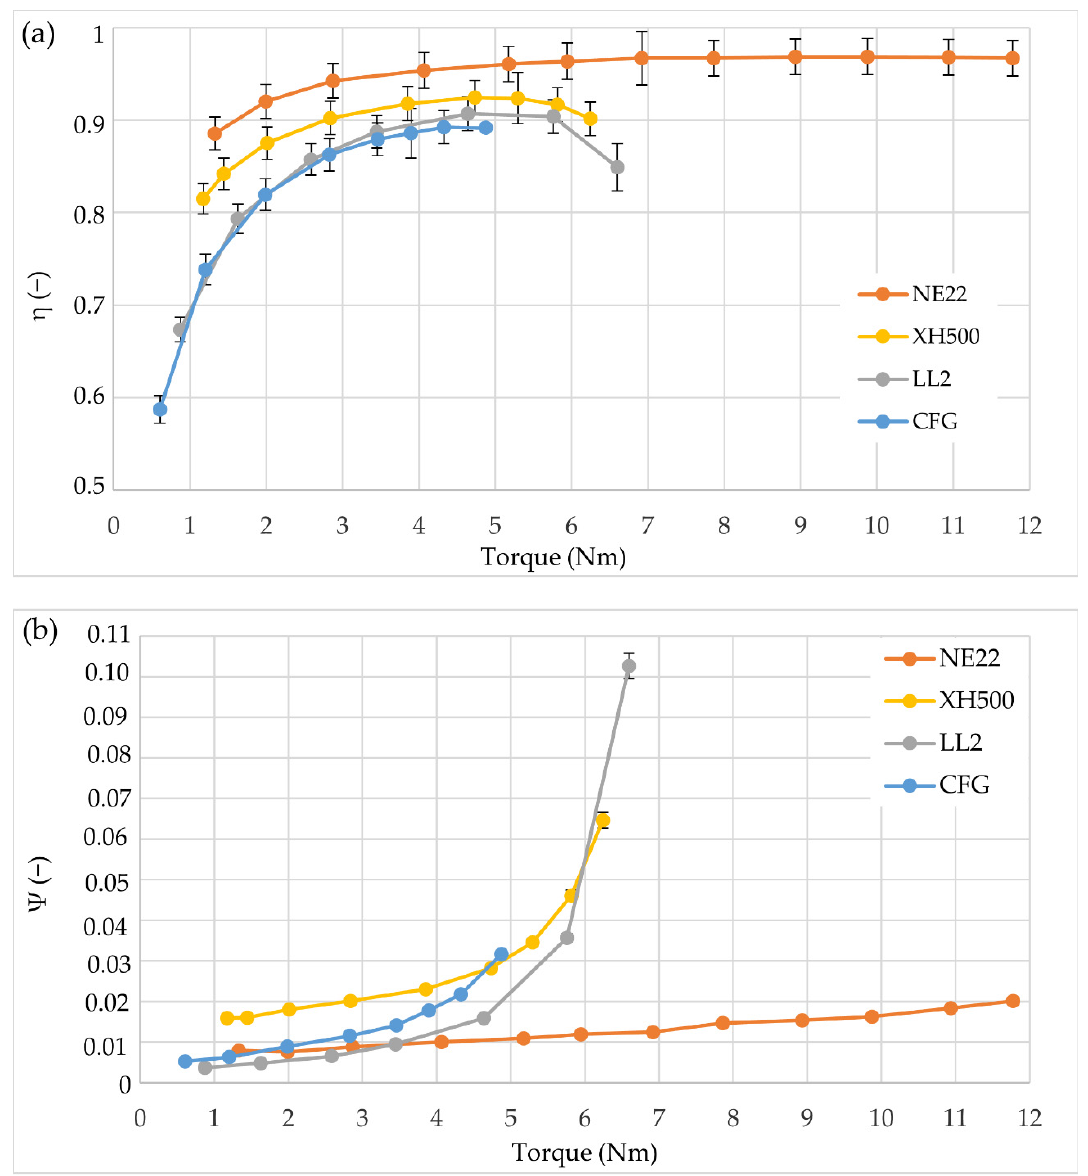
Figure 6. Variation characteristics of ( a ) efficiency as a function of torque at the idler shaft ( b ) belt slippage as a function of torque at the idler shaft for a speed of 500 rpm.